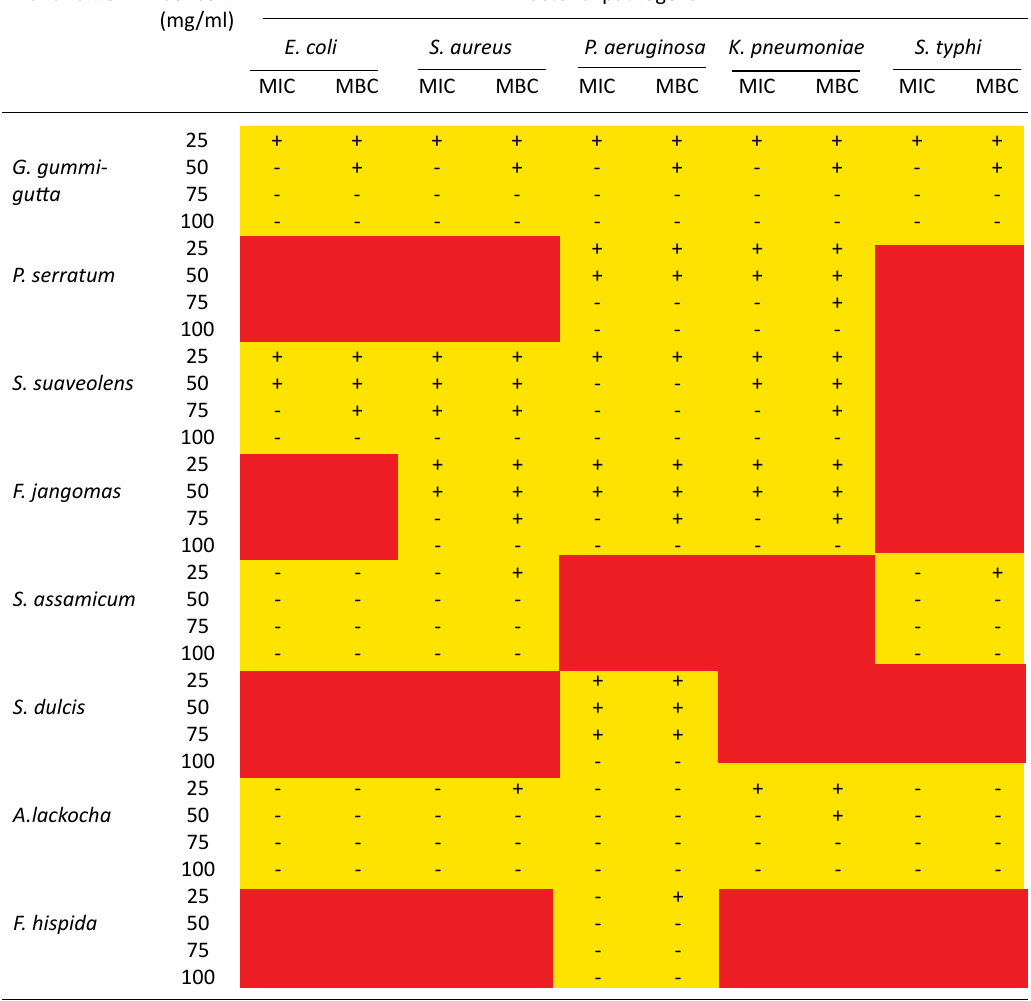
table 3. MIC and MBC value of selected fruits extracts against five bacterial strains Plant name